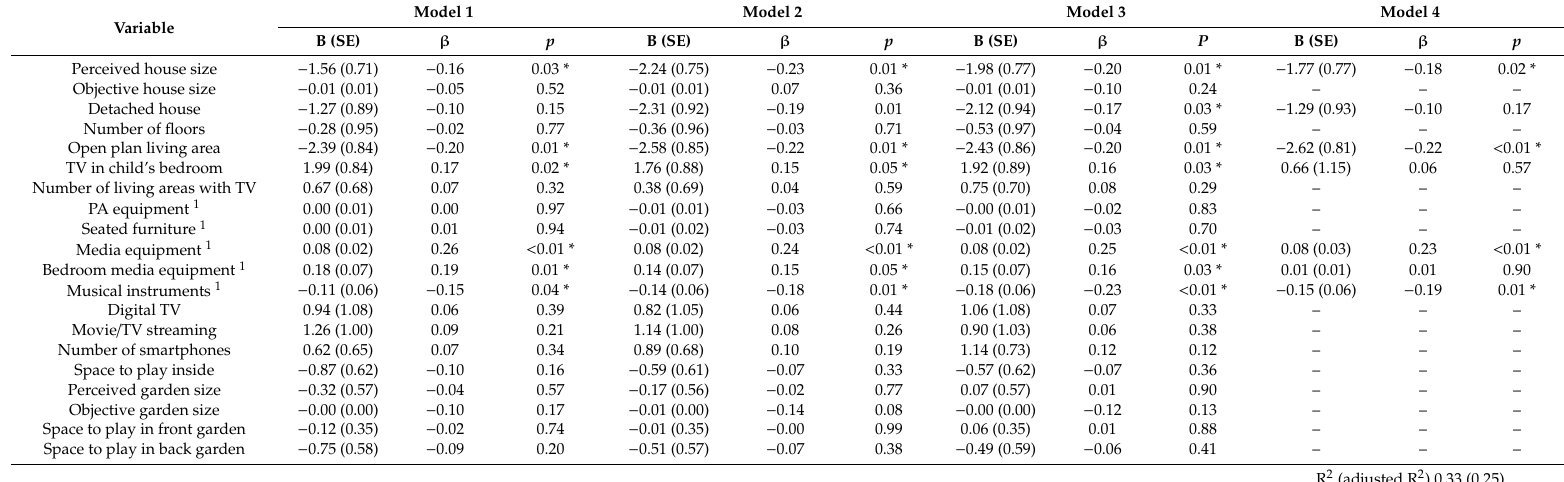
Table 2. Associations between physical home factors and children’s home-based